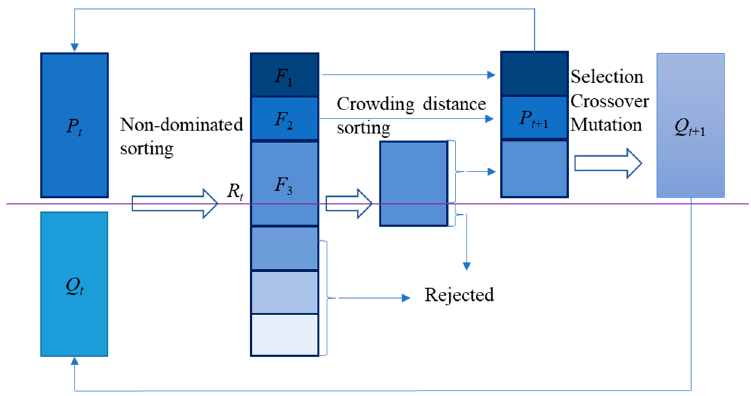
Figure 1. Schematic diagram of NSGA-II